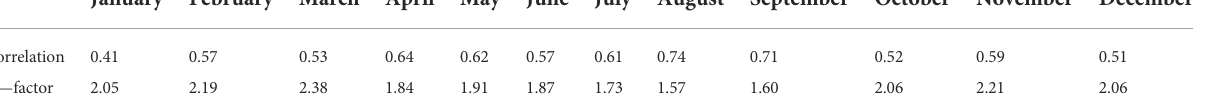
TABLE 3 The monthly averaged correlation coef fi cient ( p < 0.001) between radon-based estimation and the ERA5 data of NBL heights and calculated calculated k factor for radon-based NBL height estimation method.